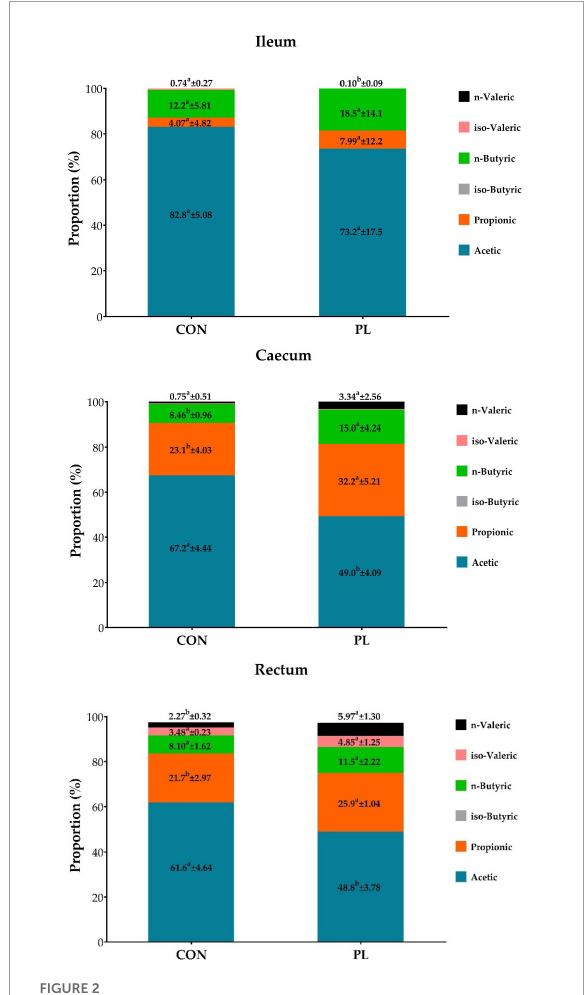
FIGURE2 Proportion (%) of individual fatty acids in the total concentration of the fatty acids in digesta of ileum, caecum and rectum of the animals in both groups at the time of dissection (mean ± SD). a , b Means within the same row with different superscripts differ significantly ( p <